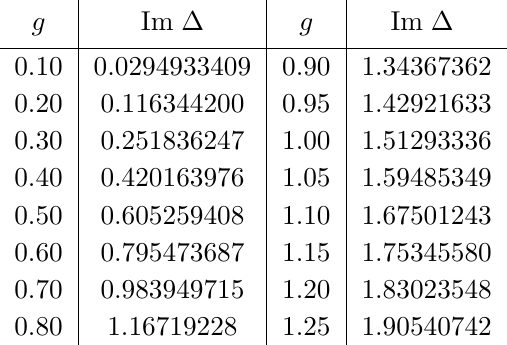
Table 1 . Numerical data for the scaling dimension at finite coupling from the Quantum Spectral Curve.